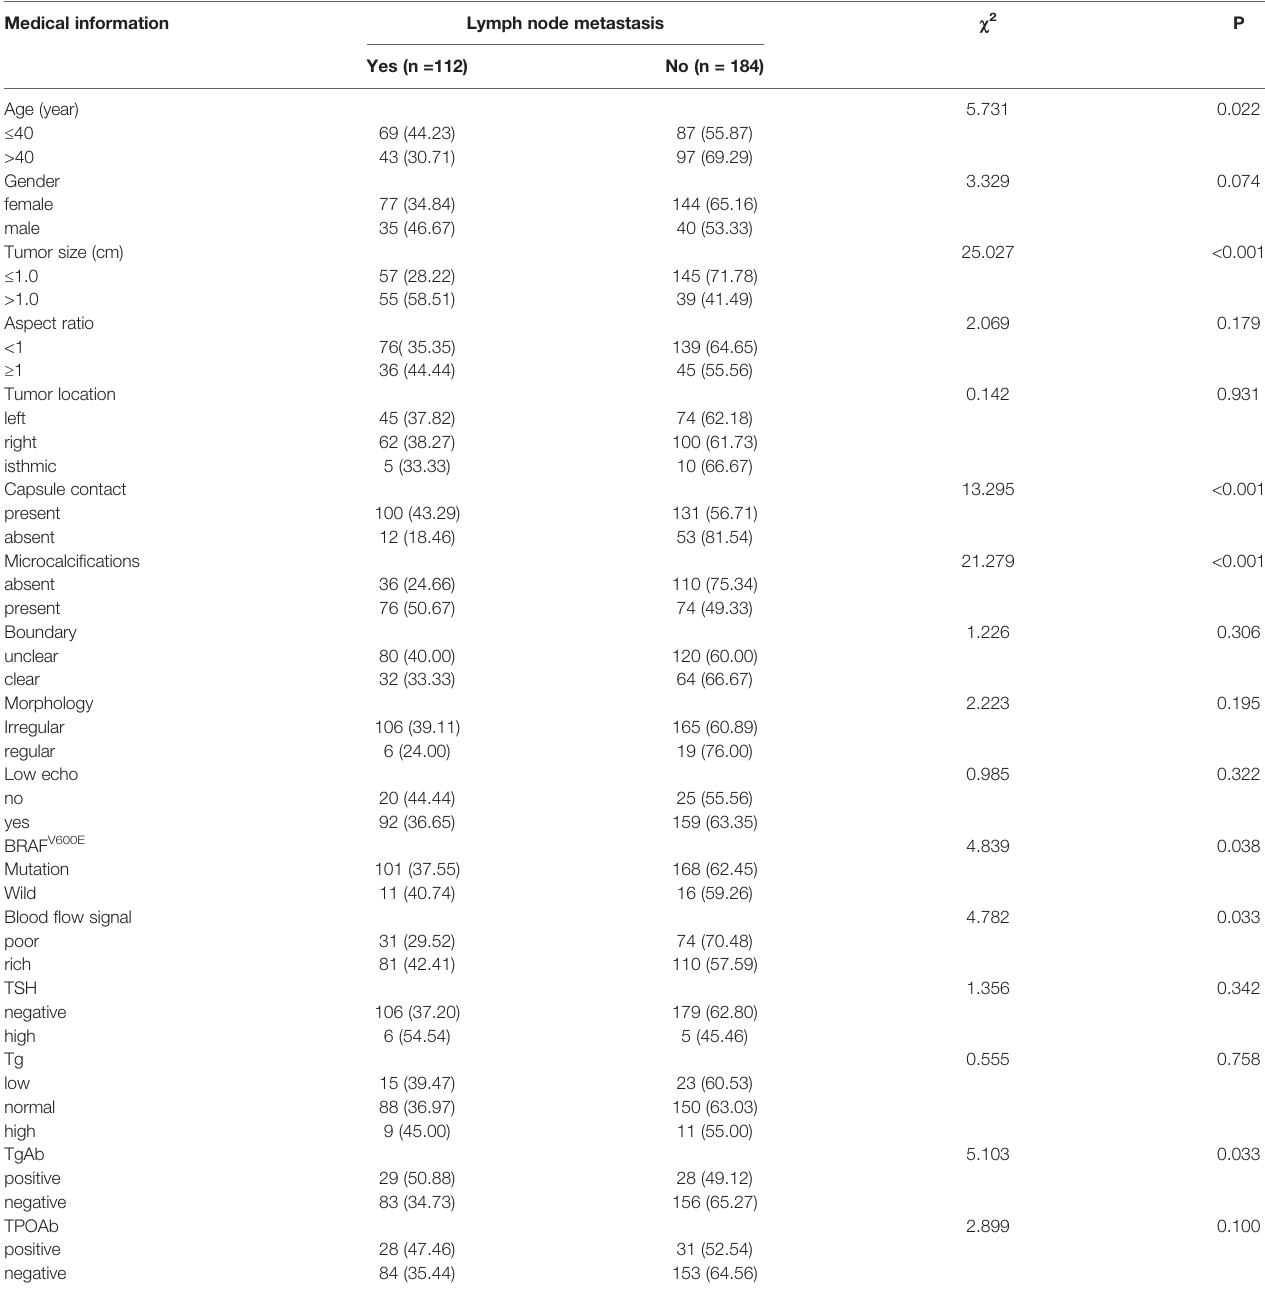
TABLE 1 | Univariate analysis of the relationship between medical information and central CLNM. Medical information Lymph node